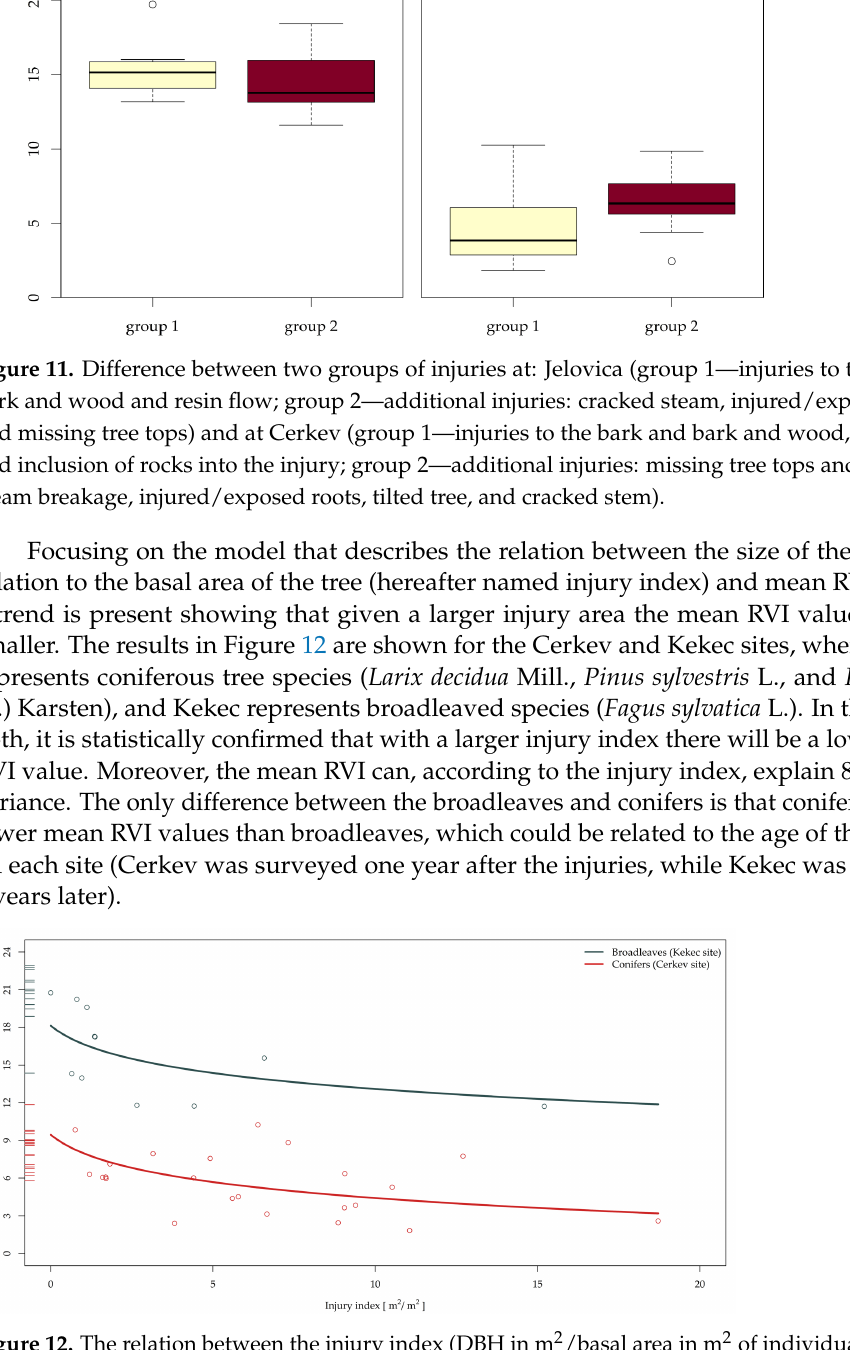
Figure 12. The relation between the injury index (DBH in m 2 /basal area in m 2 of individual tree) and mean RVI values. Data are shown for the Cerkev site (4 July 2018) for conifers and for the Kekec site (3 July 2018) for broadleaves.